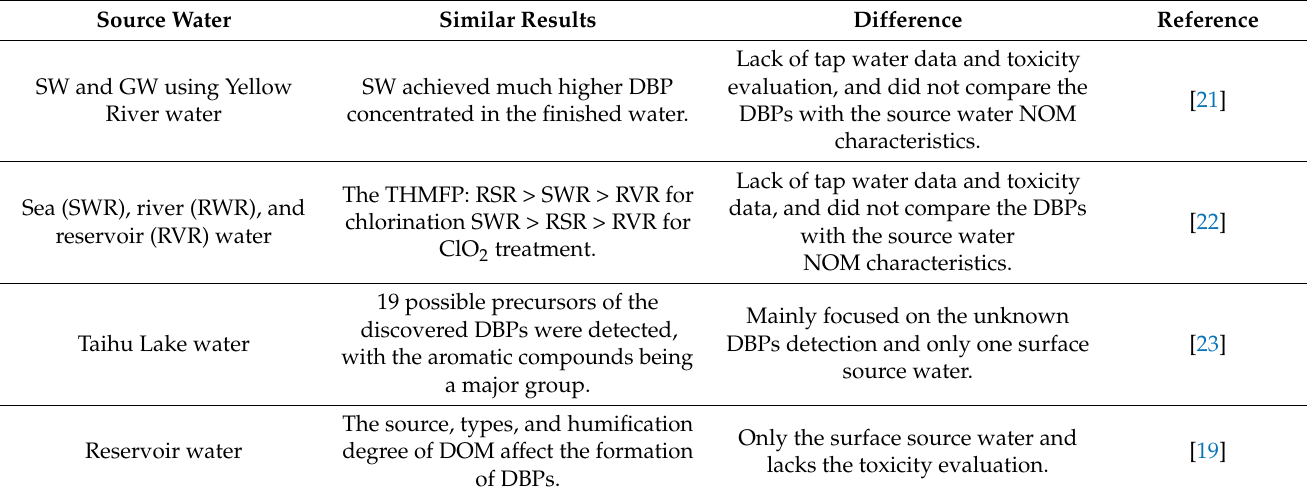
Table 1. The comparison of this work with other similar